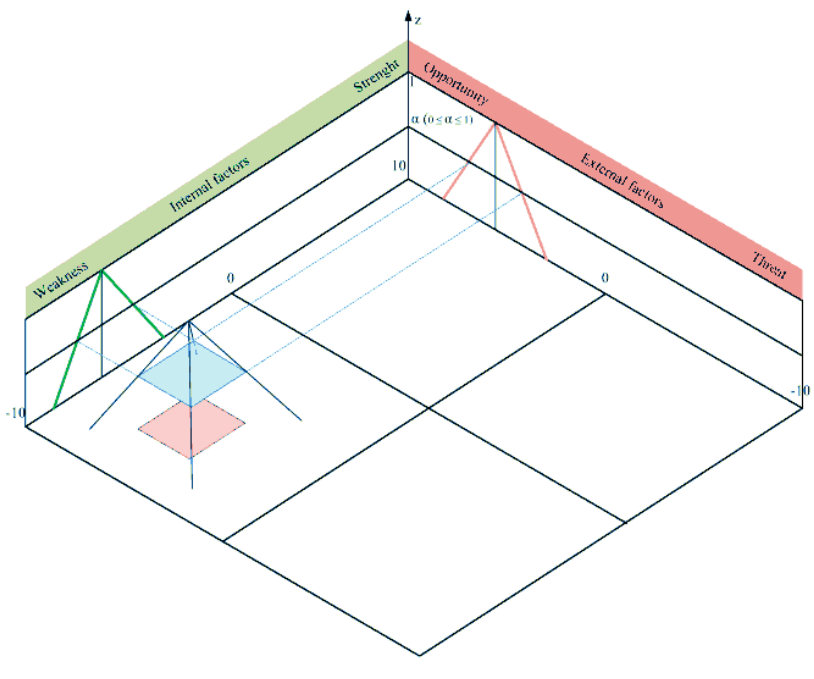
Figure 5. Defuzzification [27].